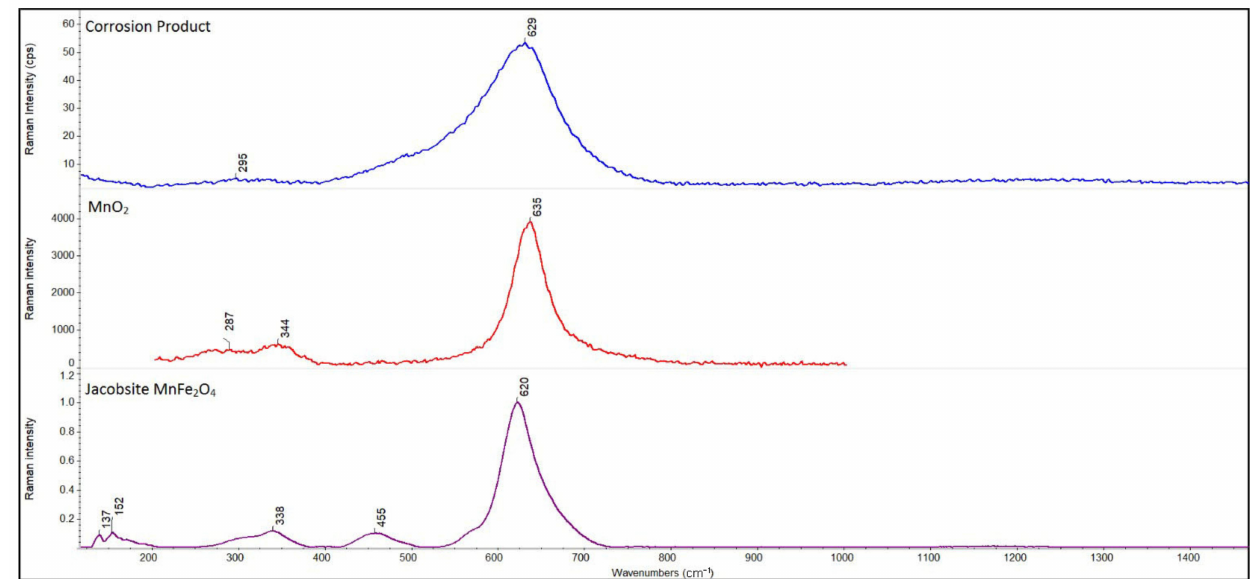
Figure 6. Raman’s spectrum of the Mn-based alloy corrosion product with the stoichiometric ratio of aluminum (exposed in model seawater).